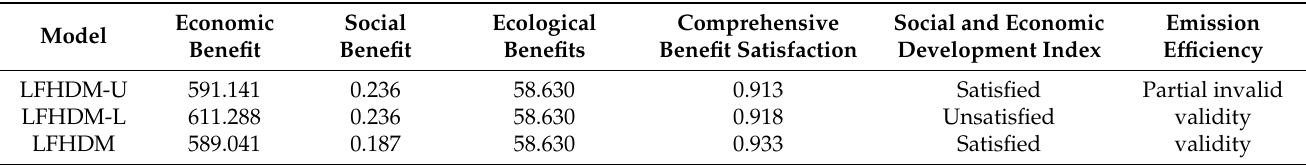
Table 4. Comparison results with single-level models.